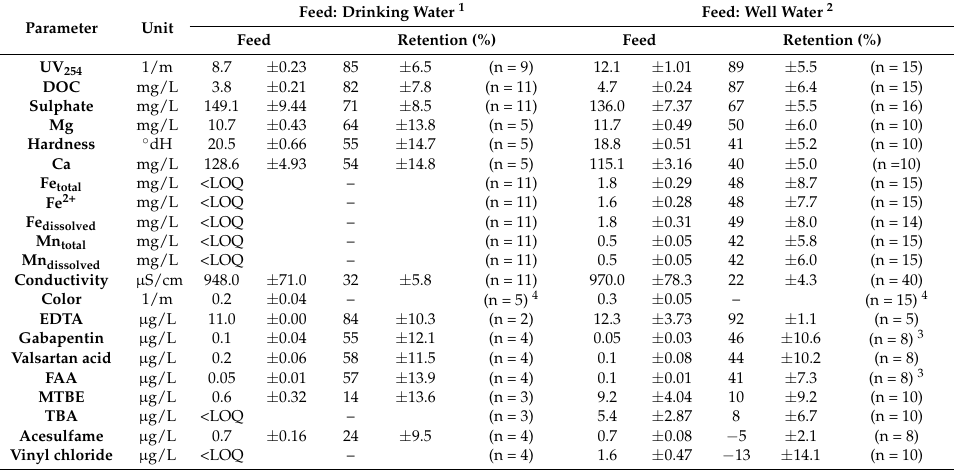
Figure 5. Feed and permeate concentrations of selected compounds; well water as feed; for permeate <LOQ the 1 LOQ was used. 2 Table 2. Feed concentrations (average and standard deviations) and retentions (average and standard deviations) of selected parameters during drinking water and well water period (for permeate <LOQ LOQ was the 1 2